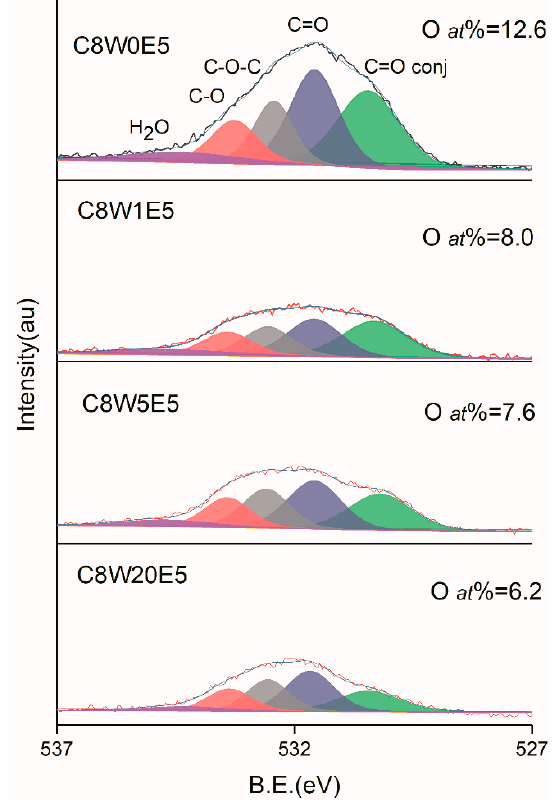
Figure 6. O1s XPS fitting curves of different samples.